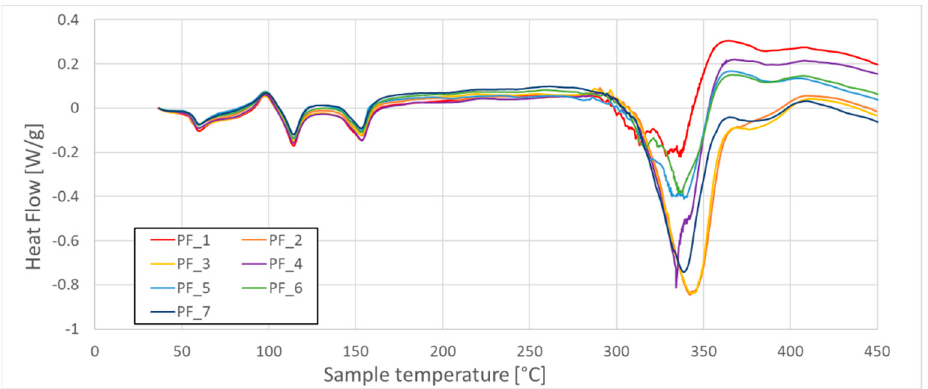
Figure 4. Heat flow (HF) of seven as-received samples of PLA-Flax (PF) filaments taken from different spools.